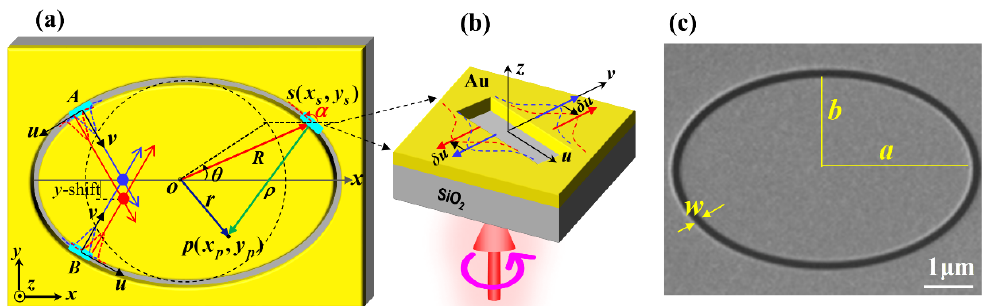
Figure 1. Schematic of a slit element of the elliptical gold nanoslit embedded on silica substrate. ( a ) Top view of the elliptical nanoslit and the basic geometric parameters. ( b ) Magnified demonstration of the shifts of the surface plasmon polaritons produced by an element. ( c ) Scanning electron microscope image of elliptical nanoslit etched using focused ion beam.